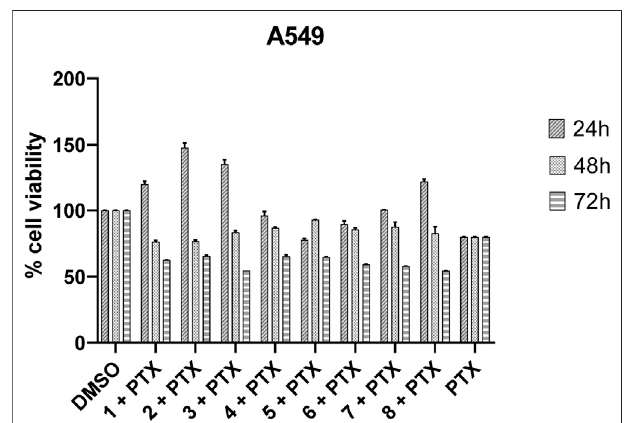
FIGURE 8 | Inhibition of A549 cell viability in cells treated with paclitaxel (800 nM)and peptides 1 – 8 (100 μ M).Cellswereplatedintriplicate in384-well plates and treated with PTX and peptides (DMSO was used as a positive control) for 24, 48, or 72 h. Cell viability was measured using CellTiter assay as described in the Materials and Methods section. Cell viability was expressedasapercentageofcontrolandeachcolumnrepresentsthemean ± SD of three independent experiments.